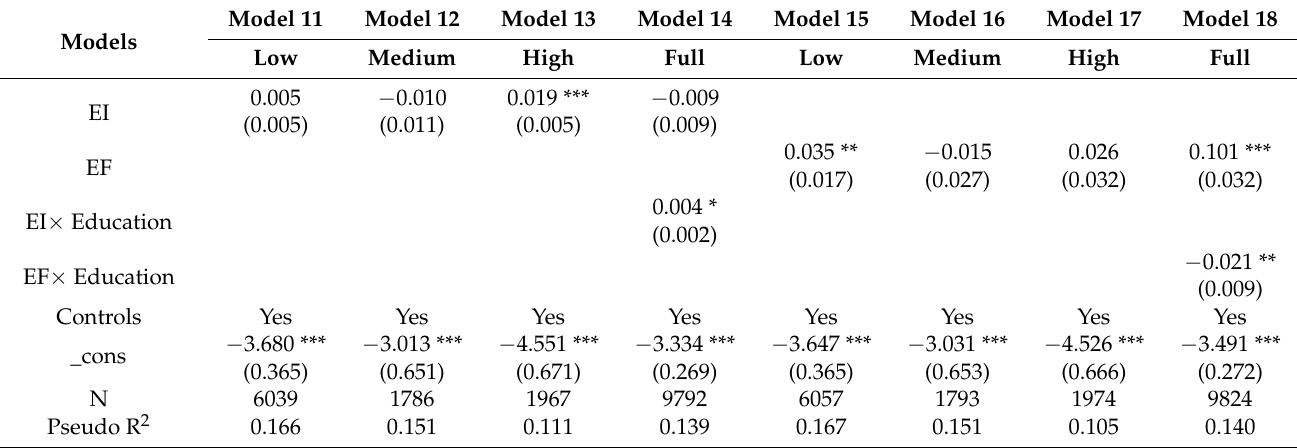
Table 4. Comparison of different education